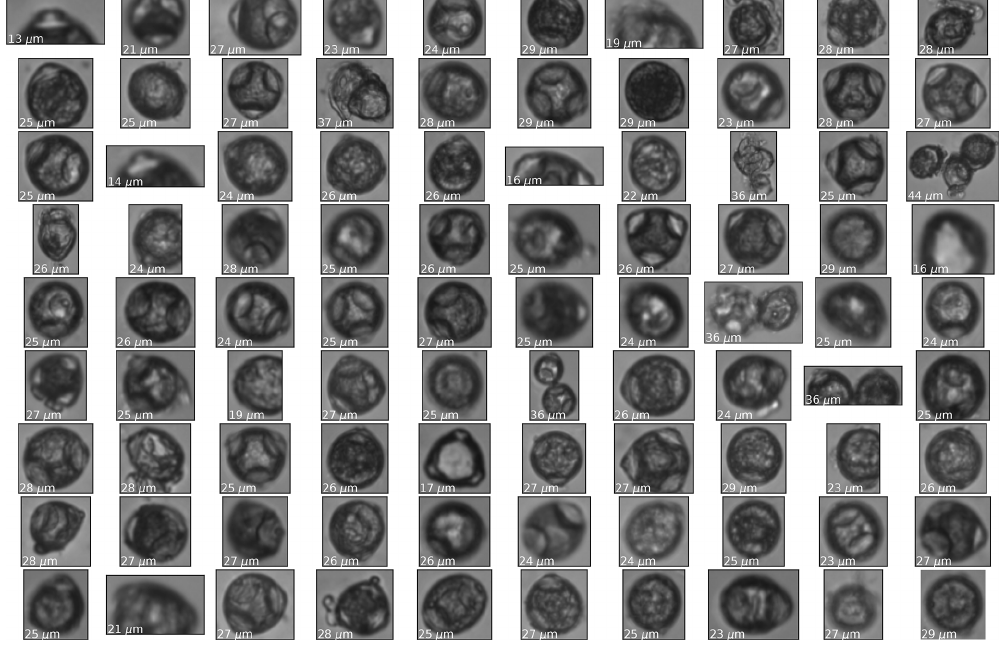
Figure C4. Corylus avellana pollen.